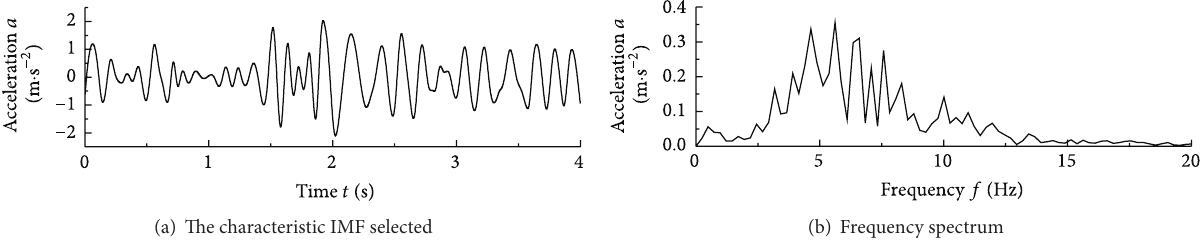
test rig. The results show that the improved EMD